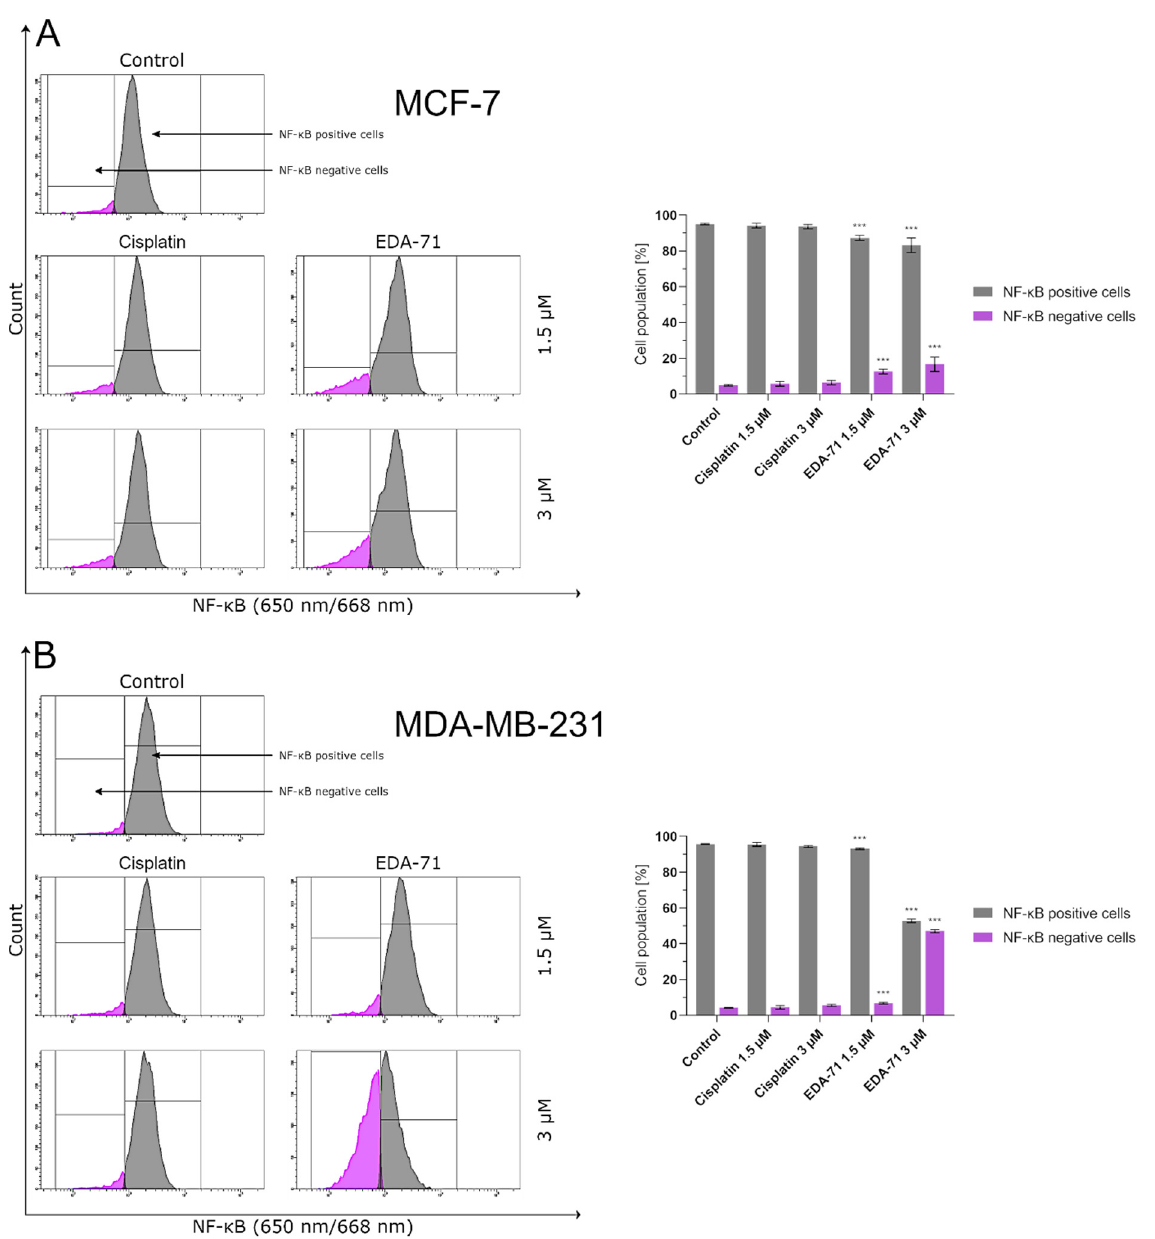
Figure 8. Cytometric analysis of NF- κ B activity in MCF-7 ( A ) and MDA-MB-231 ( B ) breast cancer cells after 24 h incubation with EDA-71 and cisplatin (1.5 and 3 µM). Results are presented as mean values ± SD obtained from three independent experiments ( n = 3) conducted in triplicate. Statistical differences between the experimental (treated cells) and control (untreated cells) groups were determined using one-way ANOVA followed by Dunnett’s test. *** p < 0.001 vs. control group.